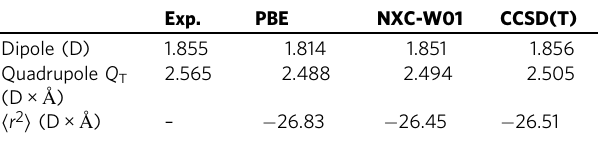
Table 3 Moments of the electronic density of